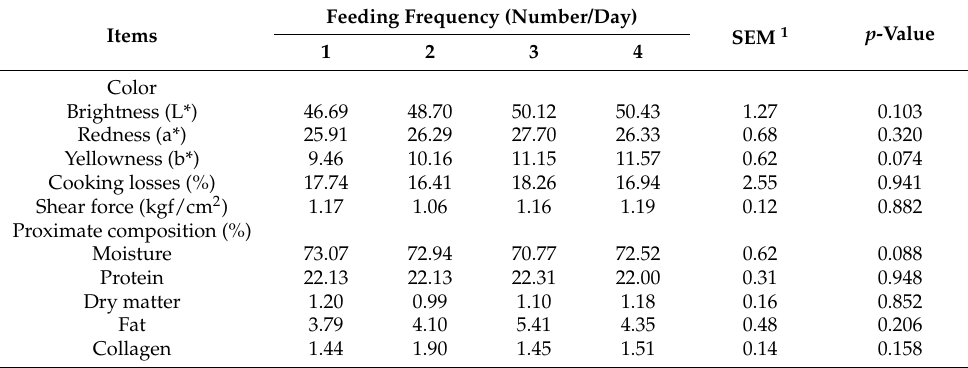
Table 5. Physicochemical characteristics and proximate composition of the Longissimus lumborum muscle of lambs subjected to different feeding